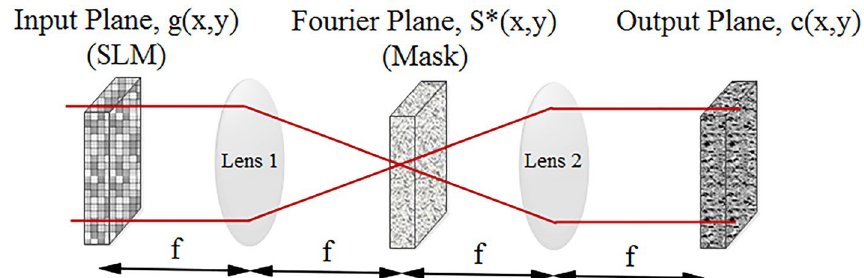
Figure 2. The schematic of 4f optical correlator.